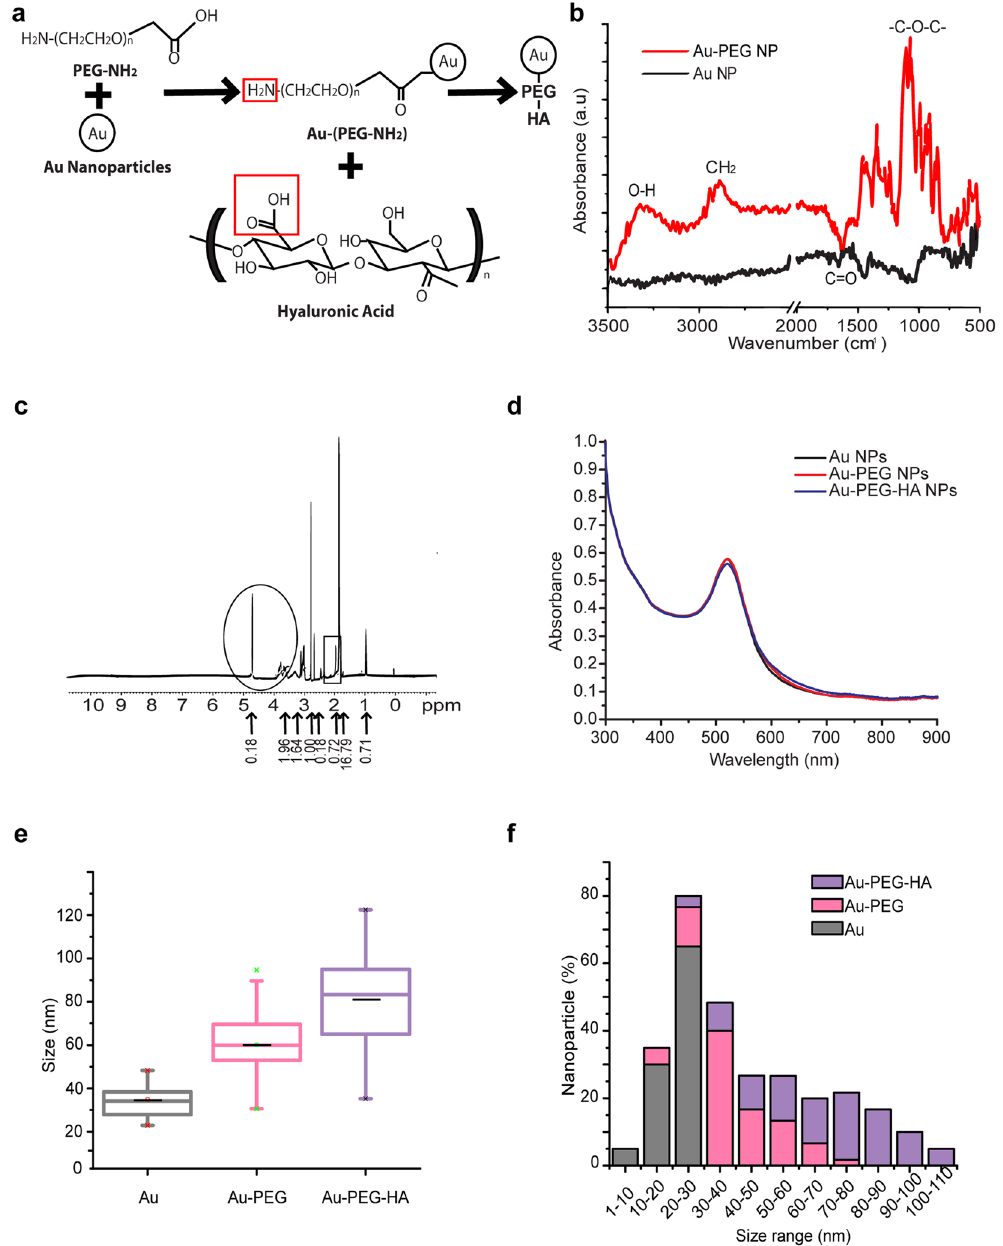
Figure 1. Physico-chemical properties of Au NPs, Au-PEG NPs, Au-PEG-HA NPs. ( a ) Schematic representation of the synthesis of Au-PEG-HA NPs. ( b ) ATR-FTIR spectrum of Au NPs and Au-PEG NPs depicting PEGylation of Au NPs (3347.17 cm − 1 - OH group, 1095 cm − 1 - C-O-C, 1637 cm − 1 - C = O stretching). ( c ) 1H NMR spectroscopy demonstrating the chemical structure of HA in Au-PEG-HA NPs with characteristics peak labeled (inset mentioned in Fig. S1a). ( d ) UV absorption spectra with a characteristic SPR peak (519– 521 nm) of Au NPs, Au-PEG NPs, Au-PEG-HA NPs. ( e,f ) Average size analysis of Au NPs, Au-PEG NPs, Au- PEG-HA NPs determined by TEM image